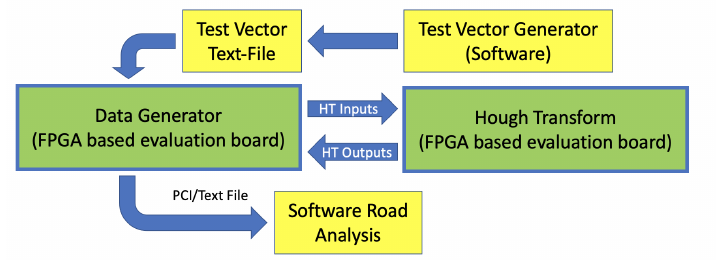
Figure 5. Logic description of the Hough transform